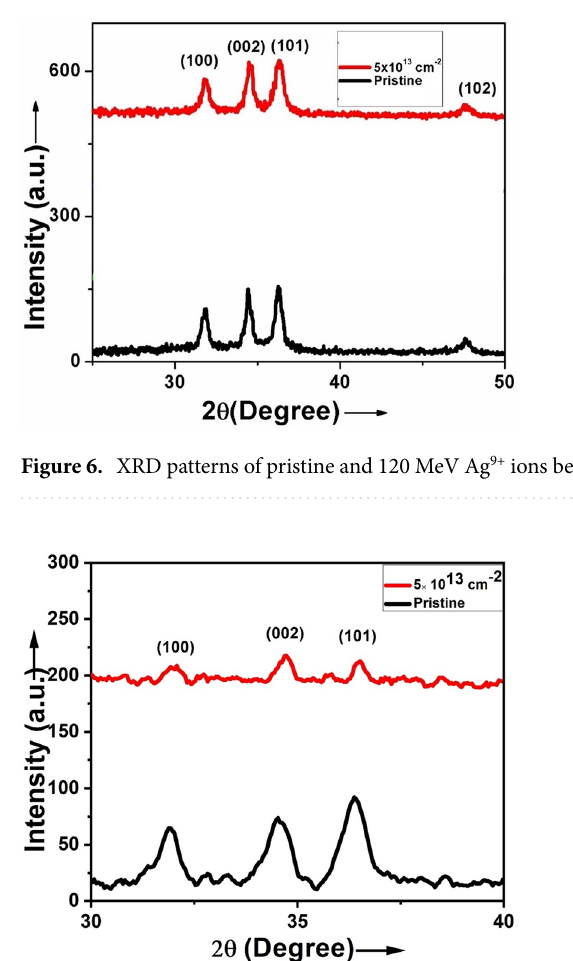
Table 1. Average crystallite size and lattice parameters of 5at.% ZnO:Ga irradiated by Ag 9+ ions and 3at.% ZnO:Ga irradiated by Si 6+ ions